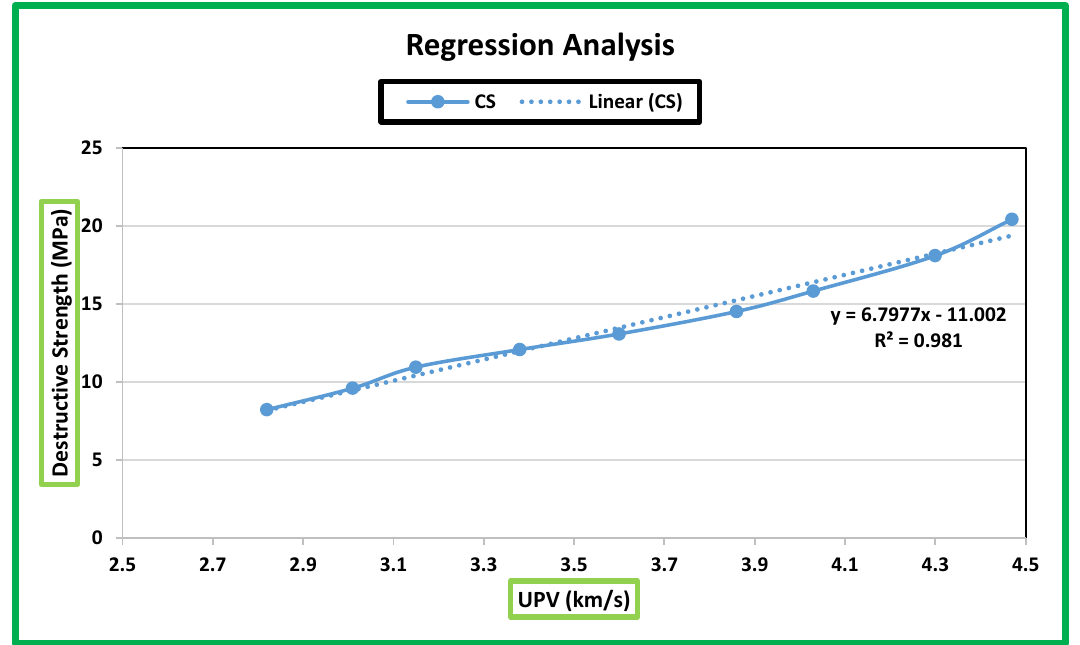
Figure 21. Regression analysis for UPV-based compressive strength (MPa). Table 10. Di ff erence between destructive strength and UPV predicted strength at 7 days.